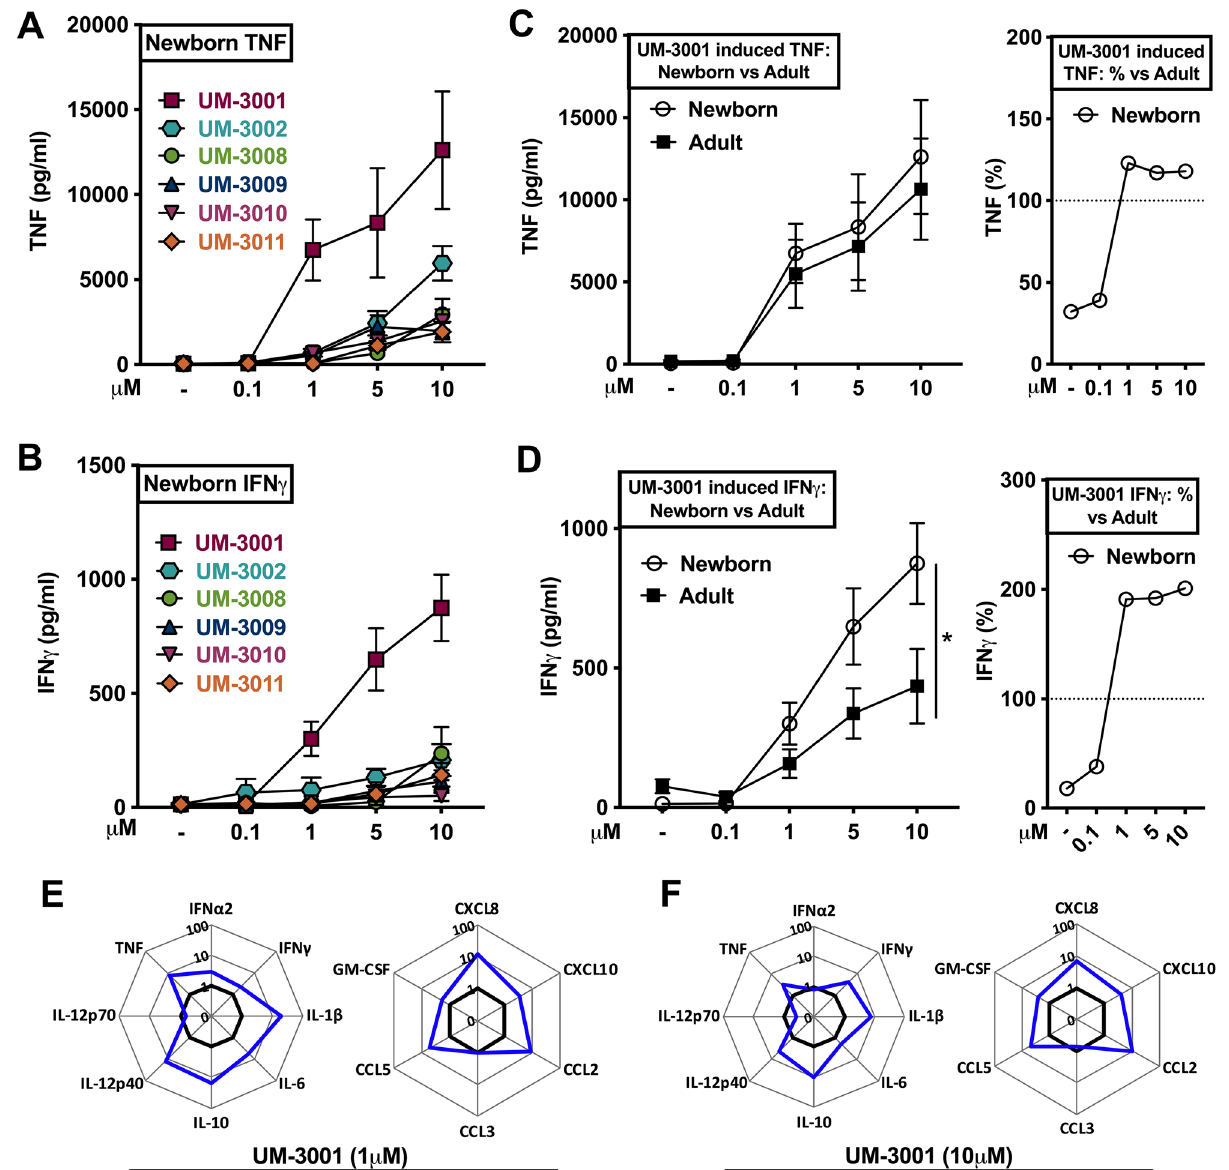
Figure 2. Imidazoquinoline UM-3001 demonstrated age-specific potency, effectiveness and IFNγ production in human newborn cord blood. ( A – B ) Human neonatal cord blood cultured in vitro for 6 h with buffer control (RPMI) or with increasing concentrations of various UM adjuvants. ( C – D ) Newborn versus adult blood cultured in vitro for 6 h with UM-3001. Supernatants were collected for ELISA. Results represent mean ± SEM, A-B; n = 7, C-D; n = 7. Cell supernatants were analyzed for cytokine expression by multiplex assay. Data are shown as fold change for newborn cord (blue line) over adult stimulated whole blood (black line) for 1 μM ( E ) and 10 μM ( F ) of UM-3001. (n = 6 adults, n = 8 newborns). For comparisons between overall groups (e.g., newborn vs. adult), two-way ANOVA followed by Tukey’s test for multiple comparisons was applied, and statistical significance denoted as * p <